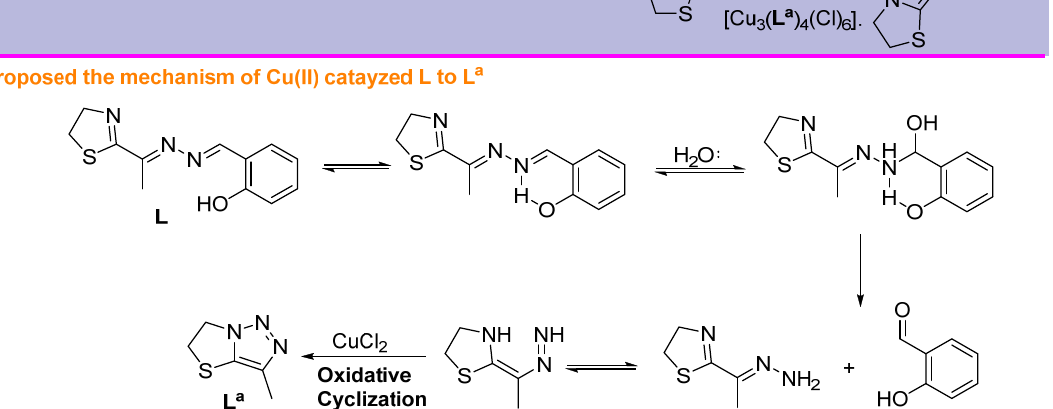
Table 1. Refinement details of the trinuclear [Cu 3 (L a ) 4 (Cl) 6 ]